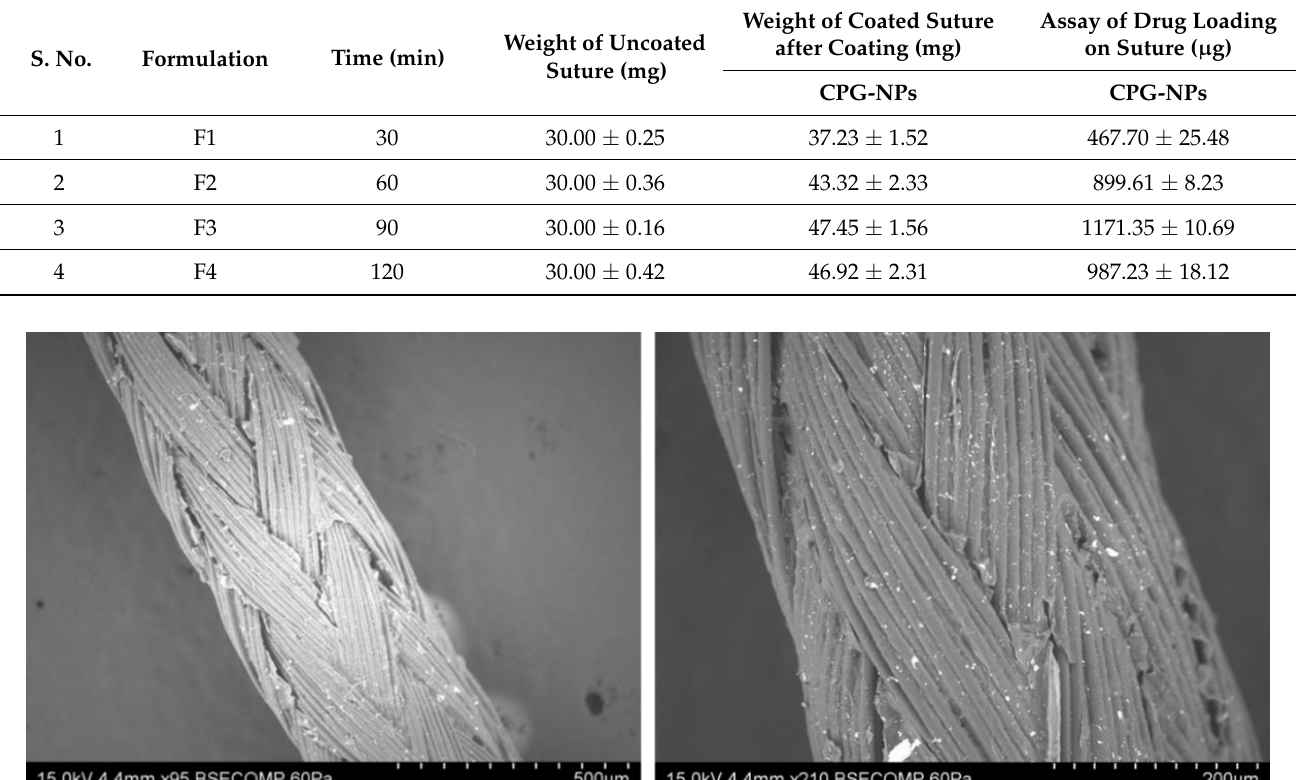
Figure 2. SEM images of CPG-NP-coated sutures at 95× and 210×.